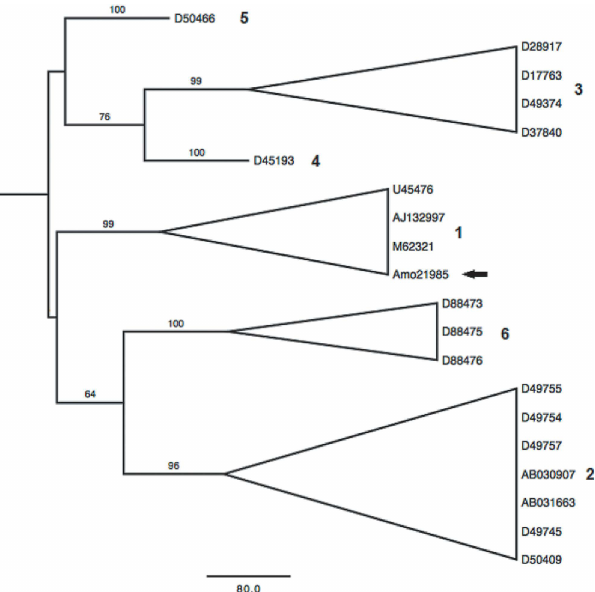
Fig 2. Phylogenetic analysis of the HCV isolated from the dental pulp. Maximum-likelihood phylogenetic tree derived from the alignmentof 269 base pairs of the 5’UTR of hepatitis C virus detected in one of the positive